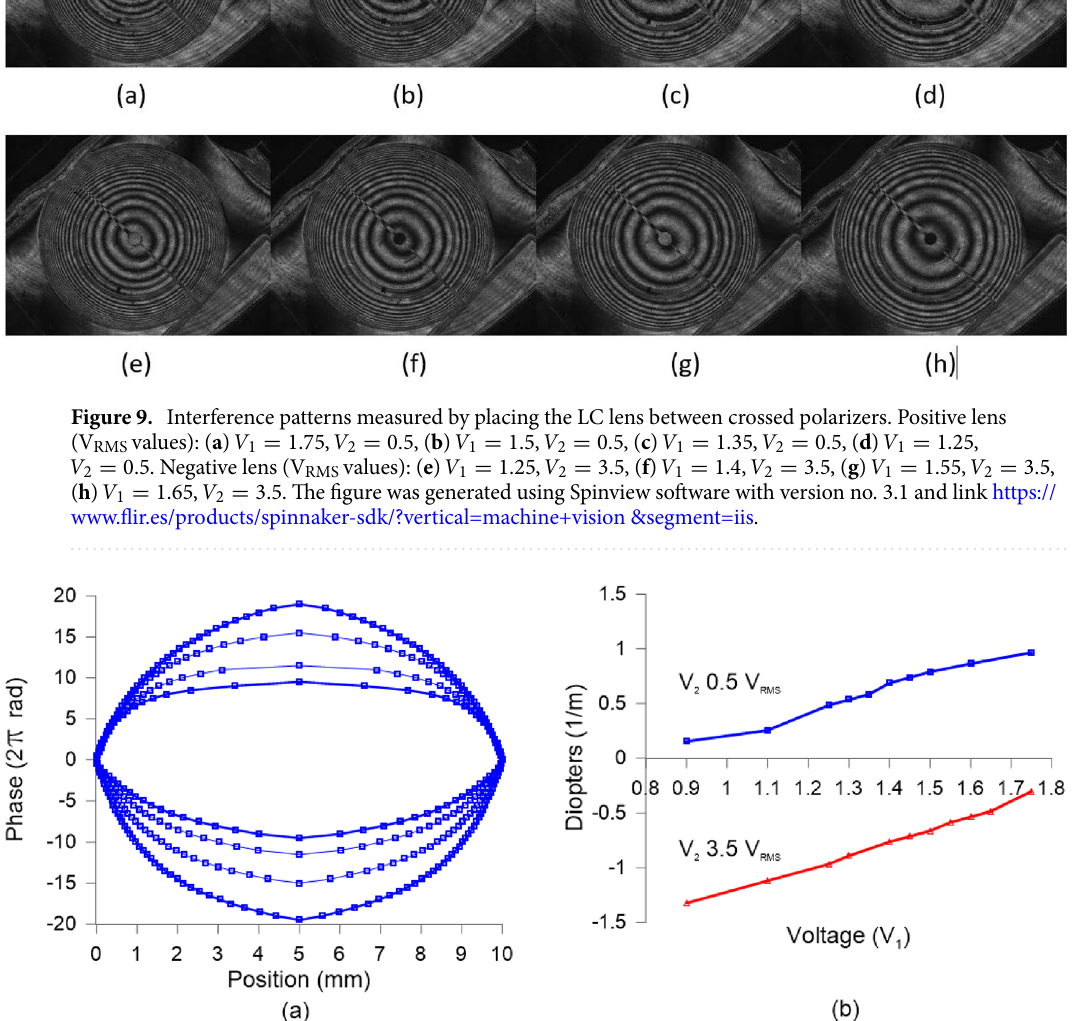
Figure 10. ( a ) Experimental phase shift profiles extracted from the fringe patterns of Fig. 5. ( b ) Optical power for different applied